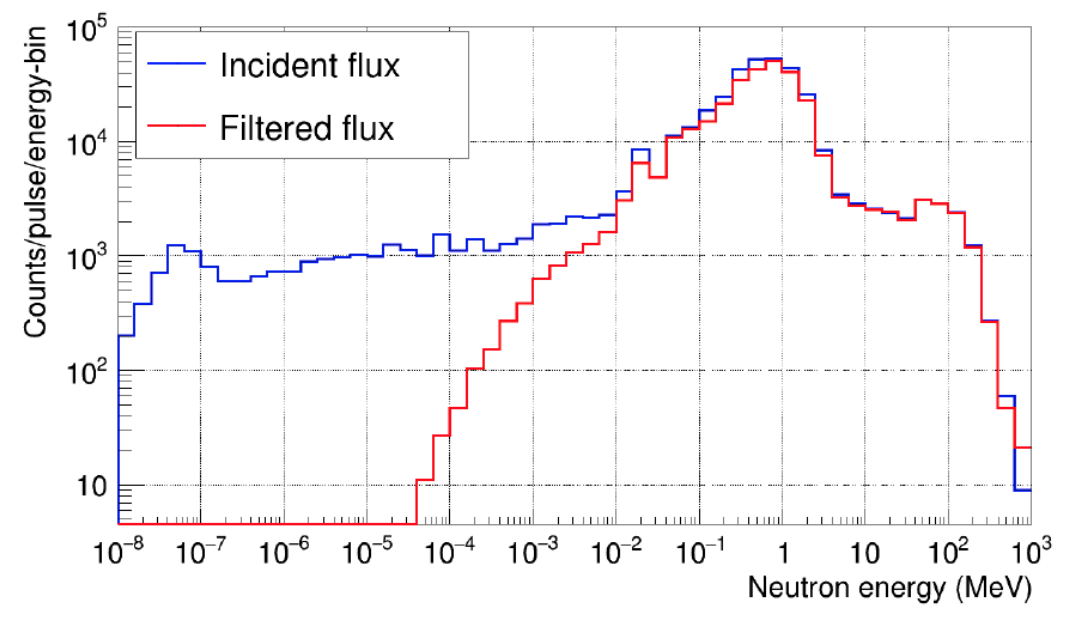
Figure 6. Expected neutron flux at the irradiation position with and without a 1.5 cm-thick boron filter. It is also necessary to reduce efficiently the effect of back-scattered neutrons from the wall of the NEAR station; for this purpose, the filter made of a slab of material requires specific modification. According to our simulations, a suitable filter consists of a boron carbide B 4 C cylinder highly enriched in 10 B. Figure 7 shows the absorption cross section of 10 B and C.